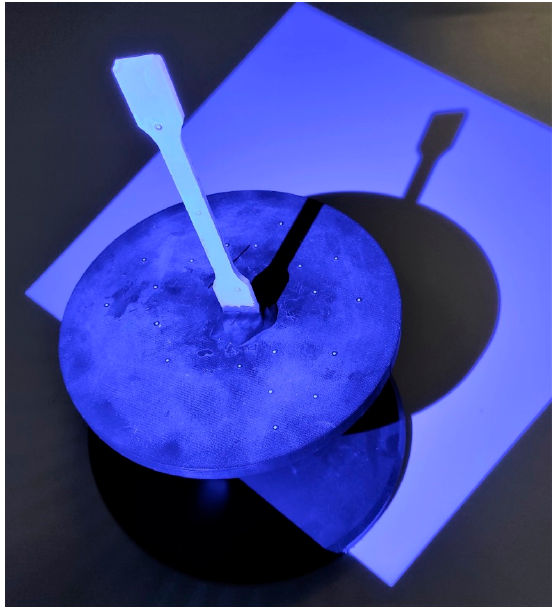
Figure 1. Polypropylene sample prepared for the 3D scanning.